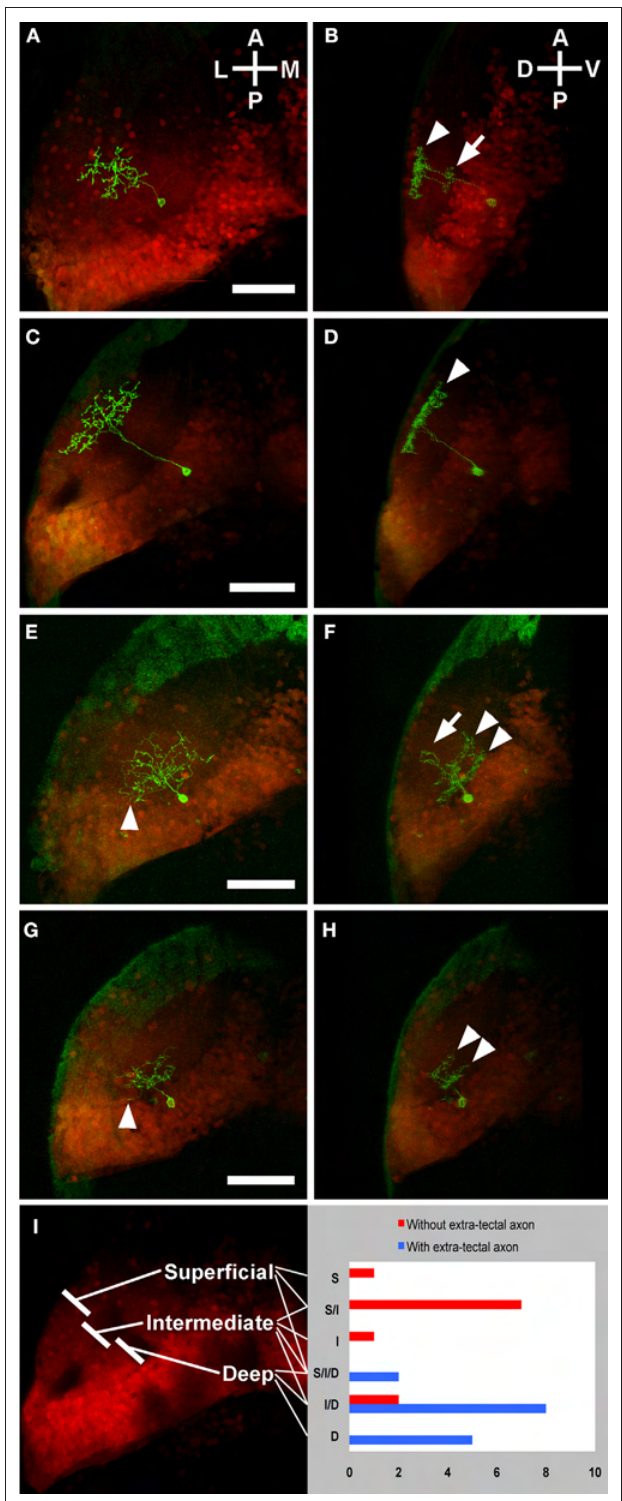
FiGUrE  | Laminar profiles of PV neurons with and without extra-tectal axons. Panels show the individual s1038t PV neurons (green) in the context of the entire s1038t tectal expression pattern (red). Each pair of panels [e.g. (A) and (B) ] comprises a dorsal image and a rotation of that image. PV neurons without extra-tectal axons typically have abundant laminated neurites in the superficial [arrowhead, (B) ] layers of the tectal neuropil, and a smaller laminated arbor in intermediate layers [arrow, (B) ]. Some of these PV neurons ( C,D ) have an exclusively superficial arbor [arrowhead, (D) ]. PV neurons with axons exiting the tectum [arrowheads in (E) and (G) ] usually have neurites in the deep [arrowheads, (F) ] and intermediate [arrow, (F) ] layers of the neuropil, or exclusively in the deep layers [arrowheads, (H) ]. (i) shows a summary of all analyzed s1038t PV neurons, indicating the regions of tectal neuropil where they have neurites and whether or not they have axons extending beyond the tectum. The number of neurons observed with dendrites in given regions or combination of regions is shown on the right side of (i) . All scale bars represent 50 μm, and apply to both panels in a pair. Orientations are approximate. All animals are 5 or 6 dpf, and are heterozygous for the s1038t Gal4 insertion, UAS Kaede , and BGUG . Supplementary movies 1 and 2 show animated z- series of (E) and (G) , and more clearly show the extratectal axons belonging to these